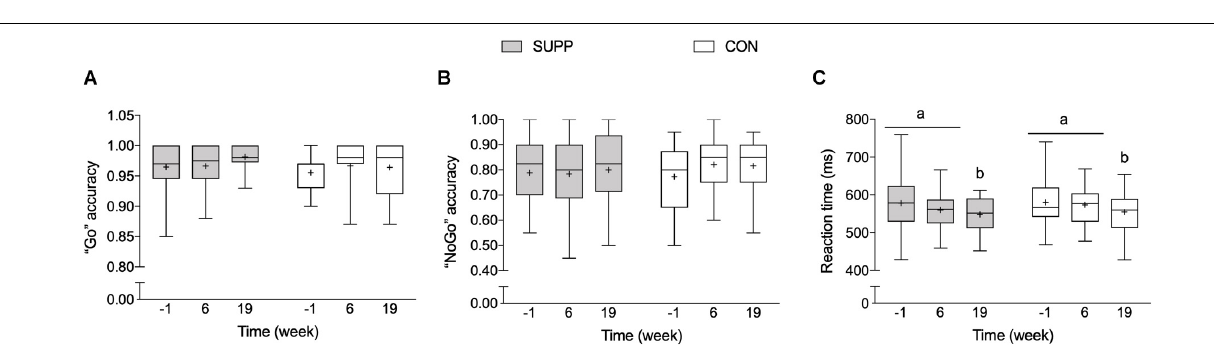
scores in the SUPP group ( (cid:49) week 19-baseline: 0.58 ± 0.62; p = 0.004; Figure 6 ); but in the CON group, this increase did not achieve statistical significance ( (cid:49) week 19-baseline: 0.31 ± 0.61; p =